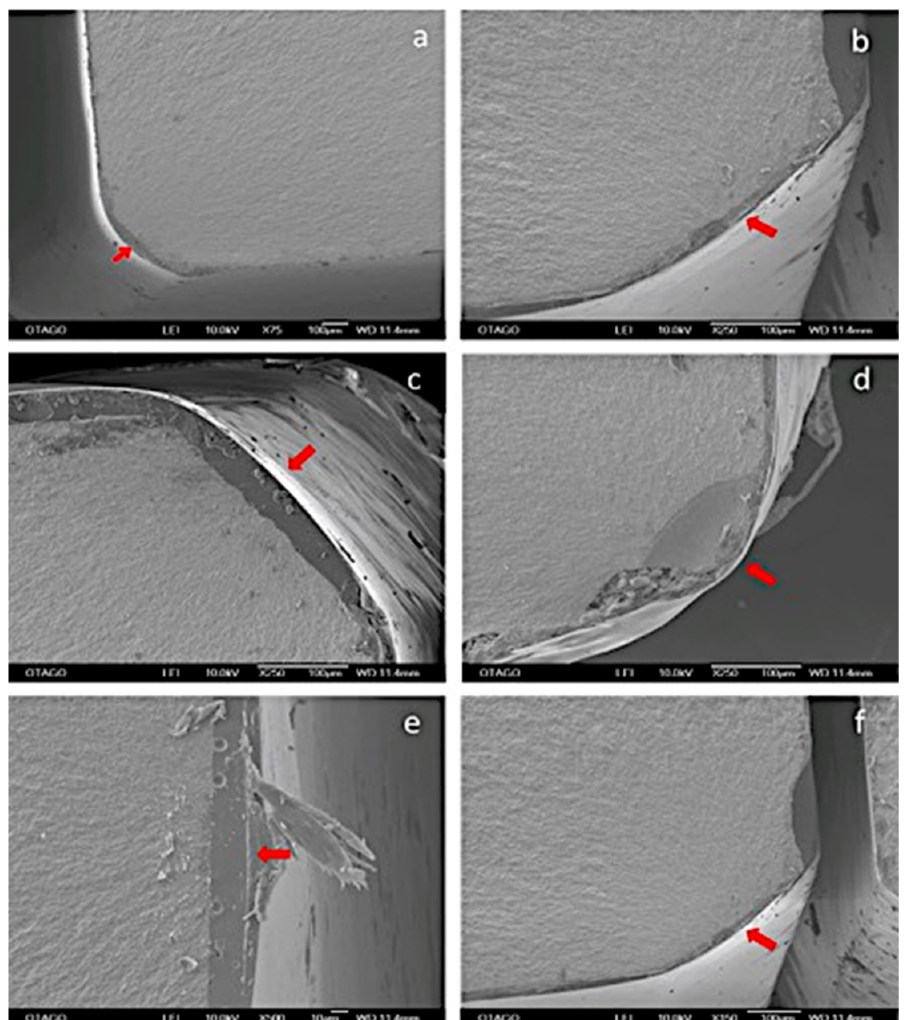
Figure 5. SEM images showing an example of fracture pattern at 25× magnification (group CP). Note the more course fractured surface for highest flexural strength specimens.